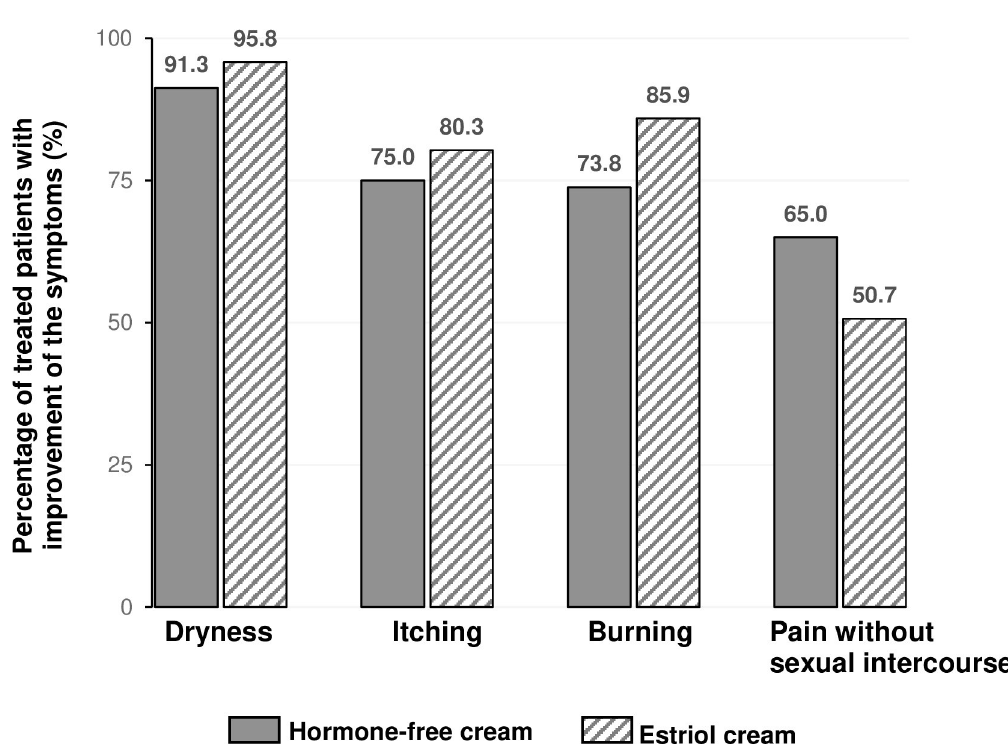
Fig 4. Vulvovaginal subjective symptoms at the end of the treatment. Percentage of treated patients with improvement of their individual subjective symptoms at the end of the treatment (Day 43). Number of patients (PP): Hormone-free moisturizing cream n = 80; Estriol cream n =